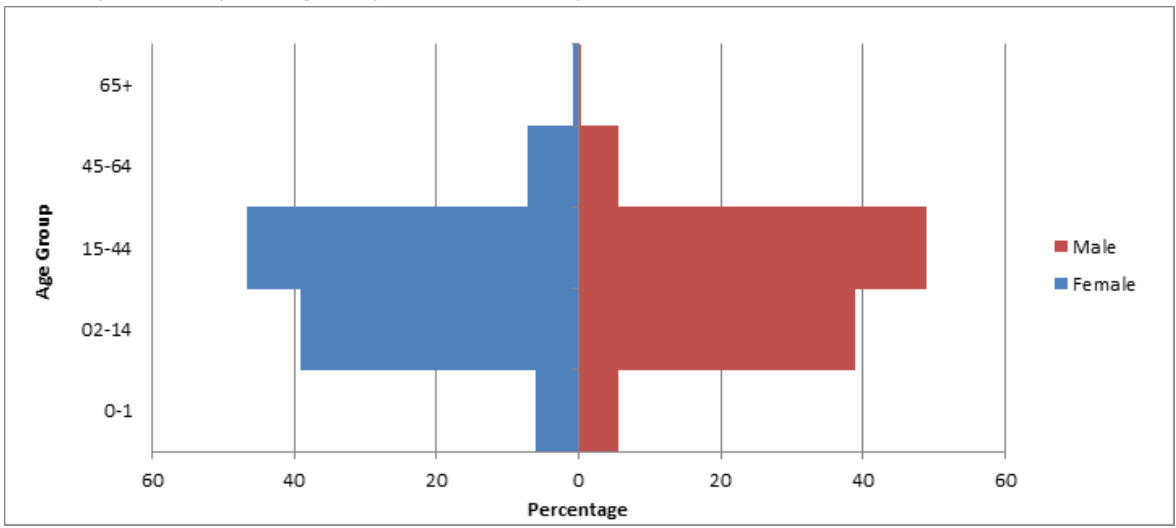
Figure 5: Age distribution for Congolese refugees originating from refugee camps in Burundi, Rwanda, Tanzania, and Uganda, 2008 – 2012